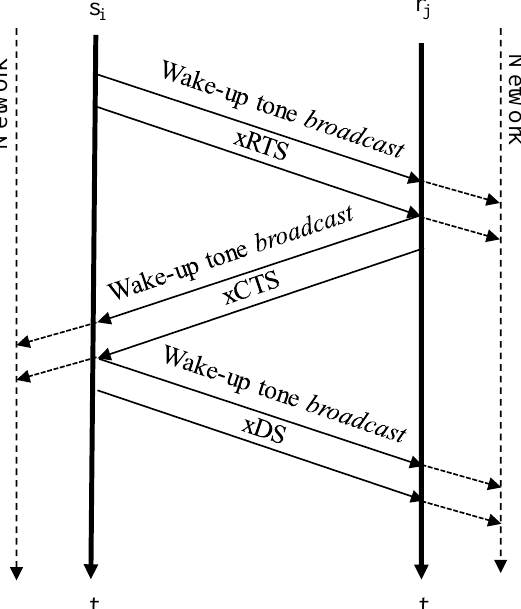
Figure 1. WU-RTS / CTS / DS handshaking with an AT-WU Figure 1. WU-RTS/CTS/DS handshaking with an AT-WU modem.